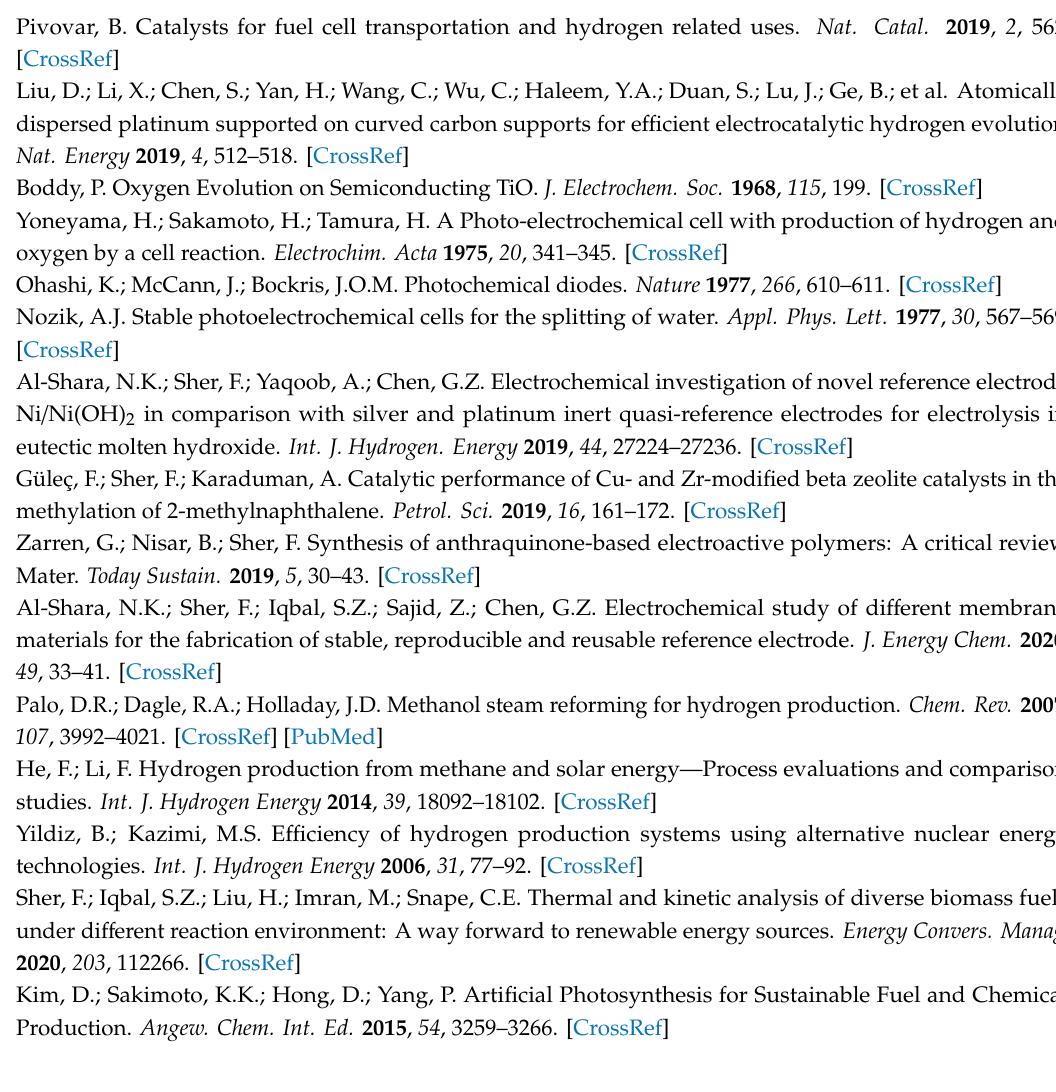
HAADF-STEM image and corresponding elemental mapping of C, N, Pt (d), Figure S7: XPS survey (a, b, c) and C 1s XPS spectra (d, e, f) for CMP-PtN4, PC-PtN4-600, and PC-PtN4-900, respectively, Figure S8: Nyquist plots of CMP-PtN4, PC-PtN4-600, and PC-PtN4-900, Figure S9: HER polarization curves of PC-PtN4-600 compared with PC-N4-600, Figure S10: CV curves of CMP-PtN4 (a), PC-PtN4-600 (b), and PC-PtN4-900 (c) with di ff erent scan rates from 20 to 200 mV s − 1 in the region of 0.3–0.4 V vs SCE, Figure S11. The time-dependent current density curve of PC-PtN4-600 was obtained at a constant overpotential of η = 31 mV for 20 h under acidic conditions (0.5 M H 2 SO 4 ), Figure S12: XPS survey (a) and C 1s XPS spectrum (b) of PC-PtN4-600 after stability test, Figure S13: HAADF-STEM image of PC-PtN4-600 after ADT. Table S1: C, N and Pt content of the as-prepared